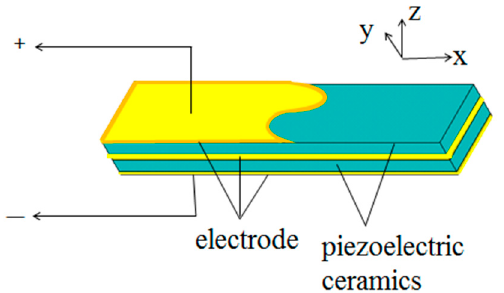
Figure 8. Structure of the piezoelectric ceramic bilaminated vibrator.